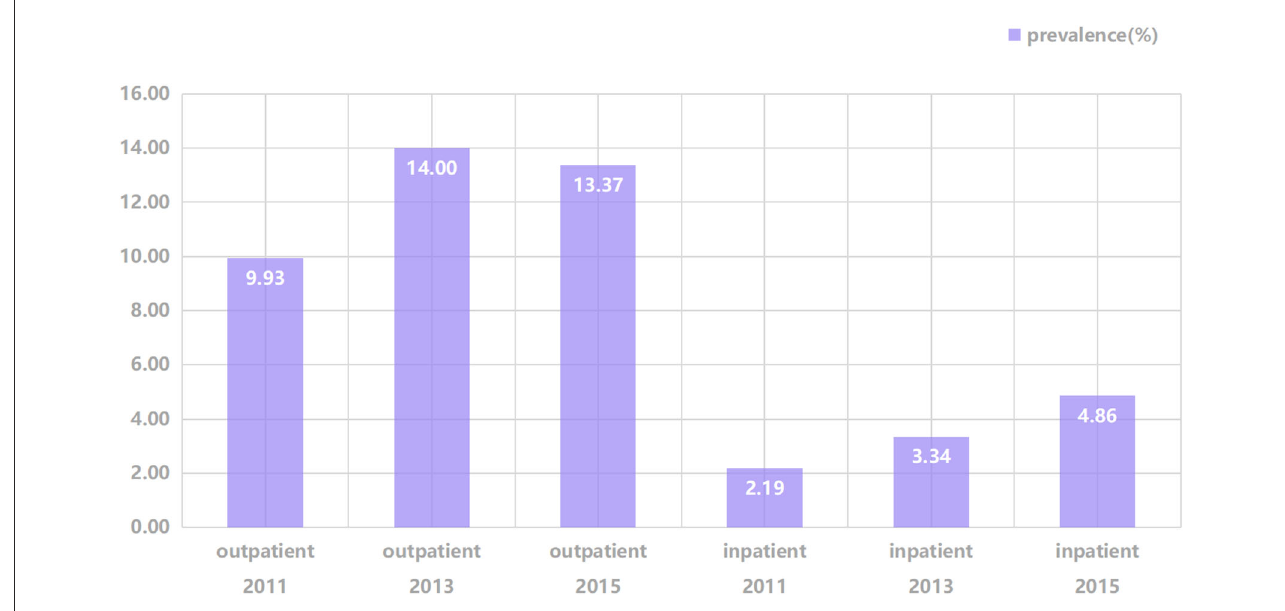
FIGURE1 Prevalence of unmet healthcare needs across survey